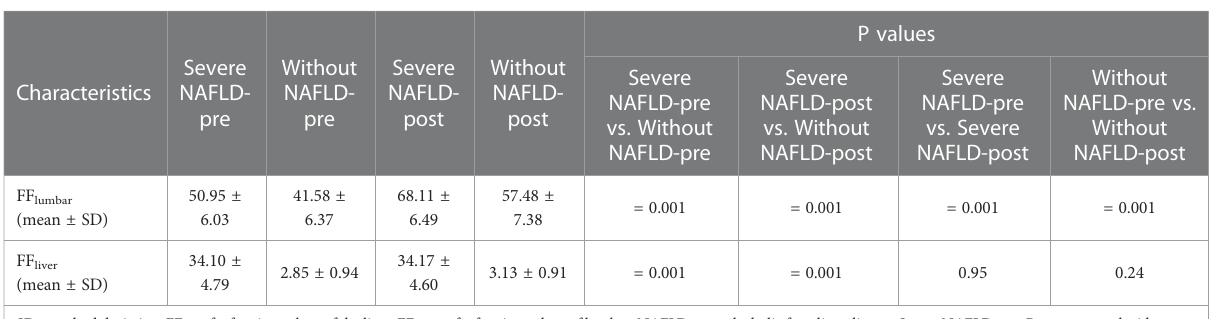
NAFLD than in patients without NAFLD (premenopausal women: 50.95 ± 6.03 vs. 41.58 ± 6.37, p < 0.001, t = 5.85; postmenopausal women: 68.11 ± 6.49 vs. 57.48 ± 7.38, p <